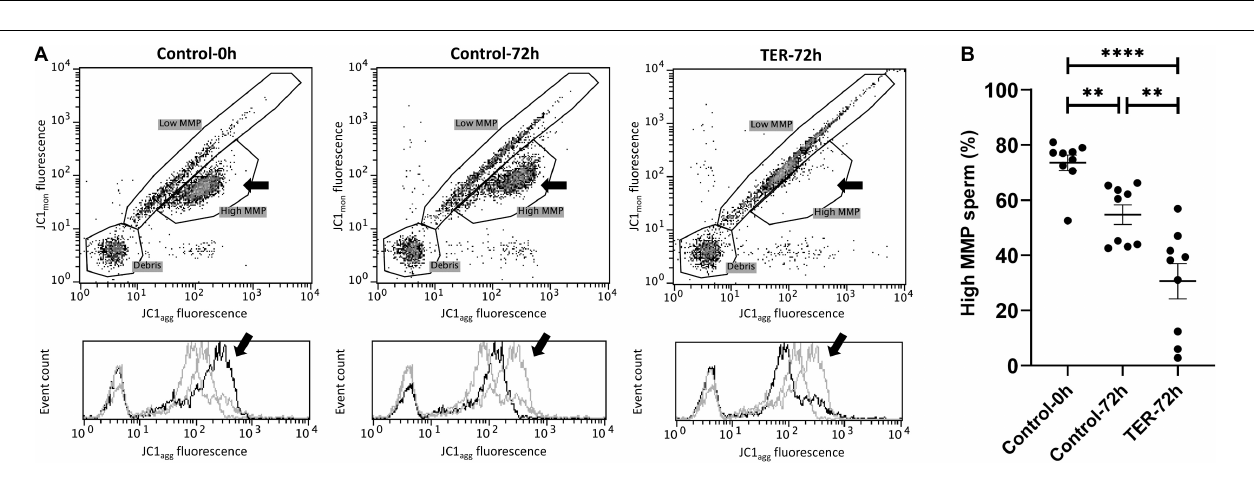
FIGURE 6 | Flow cytometry analysis of pig sperm mitochondrial activity. (A) Representative flow cytometry dot plots of JC1 monomers (JC1 mon ) and JC1 aggregates (JC1 agg ) fluorescence and histograms showing the event count of JC1 agg fluorescence intensity of all treatments. Black arrows show the flow cytometry population selected for analysis represented in (B) . Dark gray lines in histograms show the event count of its corresponding treatment, whereas light gray lines show the event count of the remaining treatments. (B) Mean, standard error of the mean (SEM), and sample distribution of the percentage of high mitochondrial membrane potential (MMP) sperm in all treatments. Control-0h, semen samples at 0 h of storage; Control-72h, vehicle control (dimethyl sulfoxide; DMSO) semen samples at 72 h of storage at 17 ◦ C; TER-72h, semen samples treated with 100 µ M ezatiostat (TER) for 72 h of storage at 17 ◦ C. Sample size ( n = 9). ** p ≤ 0.01; **** p ≤